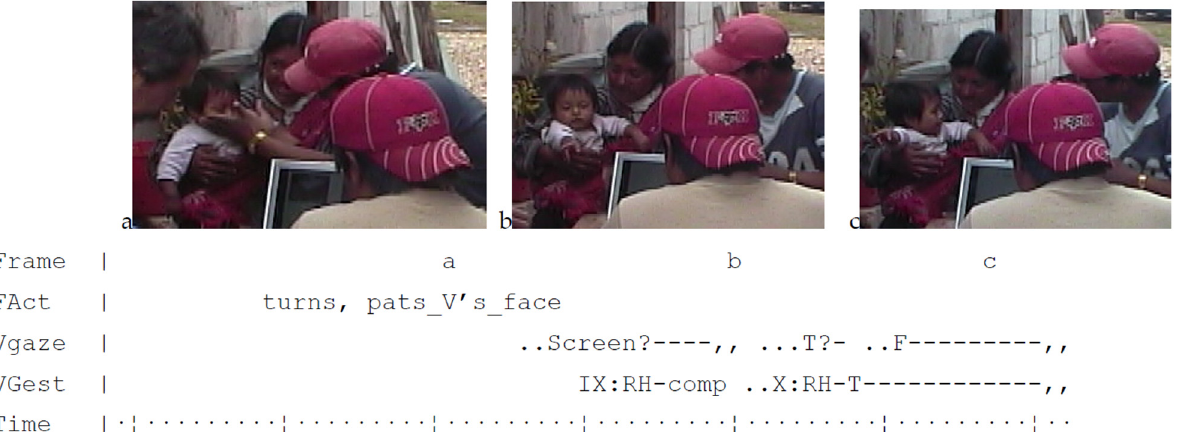
Figure 9. Vic at 12 mos. interacted with his uncle Frank. ( a ) Frank cupped the baby’s face and jokingly told him not to interfere with the work. (Frank signed WAIT to Vic, then pointed at the two signers watching the video and signed SHUSH.) In response, ( b ) Vic pointed at the two signers actively watching a video on the laptop, then ( c ) turned his gaze explicitly to Frank as if to direct his uncle’s attention to where he was pointing.